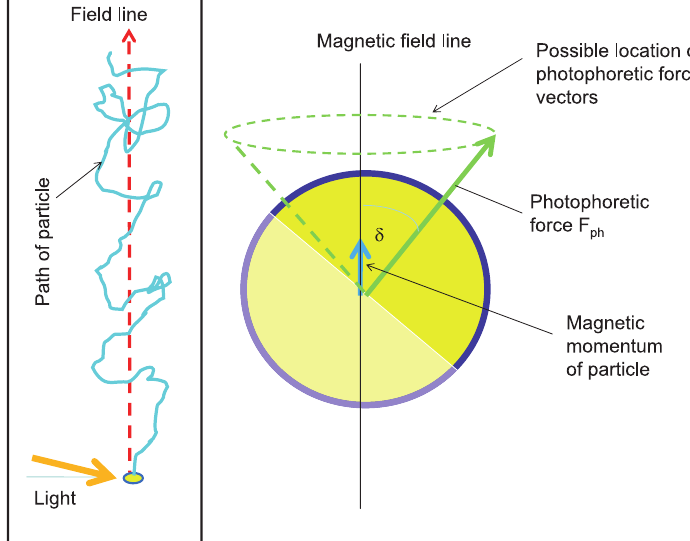
Fig. 9 Particle containing a magnetic dipole in a magnetic field. The particle is oriented such that the magnetic dipole moment points in the direction of the magnetic field. Rotation around the axis is possible, and the photophoretic force vectors are positioned on a cone with an opening angle of 2δ (right). Due to the sto- chastic manner of Brownian rotation, the particle performs a quasi-helical motion